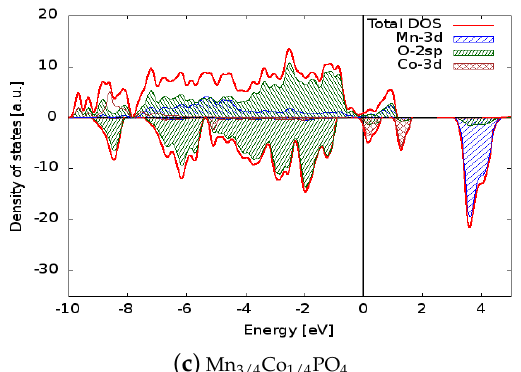
Figure 3. Comparison between the densities of states of ( a ) MnPO 4 , ( b ) Mn 3/4 Ni 1/4 PO 4 , and ( c ) Mn 3/4 Co 1/4 PO 4 . The Fermi energy was set to zero to allow direct comparison of the electronic structures. The positive (negative) axis is the majority (minority) spin direction. All materials have metallic behaviour. Projected densities of states on transition metal atoms and oxygen are also reported.